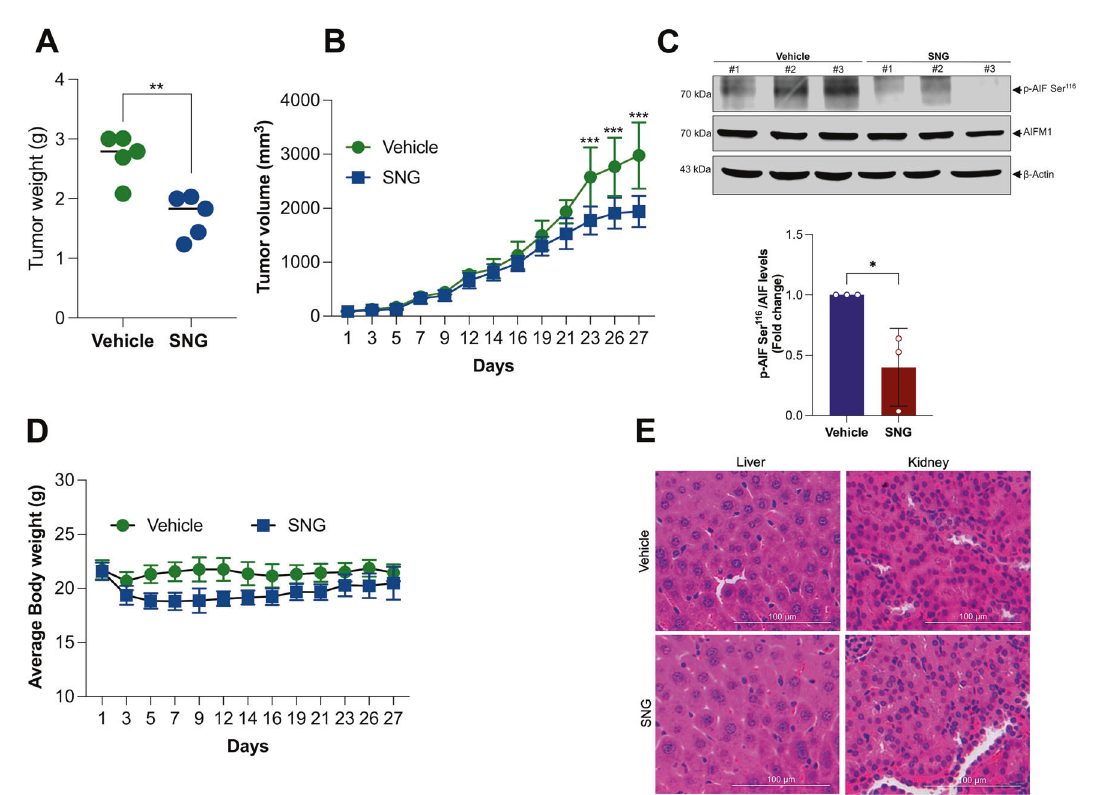
Fig. 6 Pivotal role of KEAP1-PGAM5-AIFM1 signaling axis in SNG-induced oxeiptosis. CRC cells were stably transfected with PGAM5- shRNAs. After transfection, cells were treated with SNG (4 μ M) for 16 h. Following the treatment, A Western blot analysis of indicated proteins was performed. The signal intensities of western blot bands were normalized to AIFM1 or actin of each group, and fold changes were plotted in a histogram from three independent experiments. Signi fi cant difference, ** p < 0.01 and *** p < 0.001. B CRC cells were stably transfected with PGAM5-shRNAs. After transfection, cells were treated with the indicated concentration of SNG for 16 h and then cell viability was measured by MTT assay. Data shown are mean ± SD ( n = 3) (* p < 0.05, ** p < 0.01 and *** p < 0.001) and C crystal violet staining was performed. Scale bar: 10 µm. Indicated cells were stably transfected with AIFM1-shRNA, after transfection, cells were treated with the indicated concentrations of SNG (HT-29 for 16 h and CaCo-2 for 6 h), respectively. Following the treatment, D and E cell viability was measured by MTT assay. Data shown are mean ± SD ( n = 3) (* p < 0.05, ** p < 0.01 and *** p < 0.001), and F crystal violet staining was performed. Scale bar: 10 µm. G HT-29 cells were treated with SNG in the presence or absence of NAC for 16 h. Whole cell lysates of treated as well as untreated cells were subjected to immunoprecipitation with the respective antibodies as indicated, followed by detection precipitates (top) and input lysates (bottom) with the appropriate antibodies by Western blotting. HT-29 cells co-treated with H 2 O 2 (250 μ M) were exposed to SNG (2 μ M) in the presence or absence of NAC. H Western blot analysis of indicated proteins was performed. The signal intensities of western blot bands were normalized to AIFM1 of each group, and fold changes were plotted in a histogram from three independent experiments. Signi fi cant